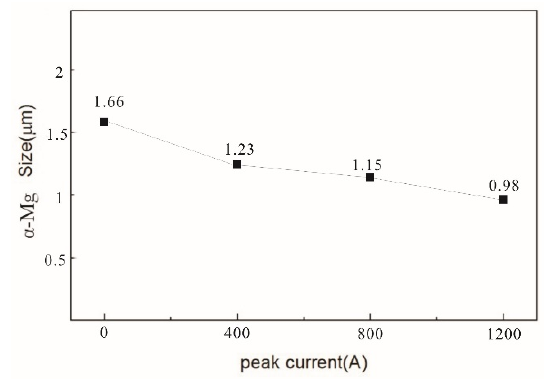
Figure 8. SiC p /AZ91: average grain size of the composites.